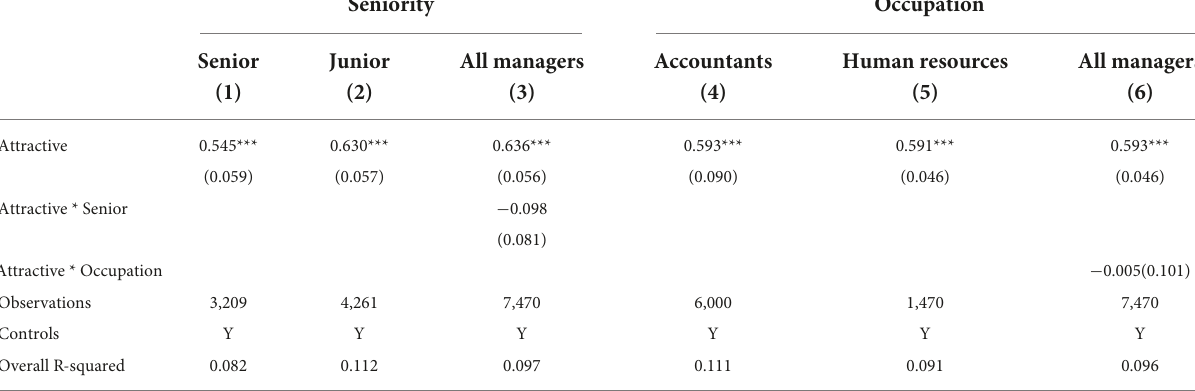
TABLE 6 The effect of attractiveness on the tendency to hire a candidate by managers’ seniority and occupation.